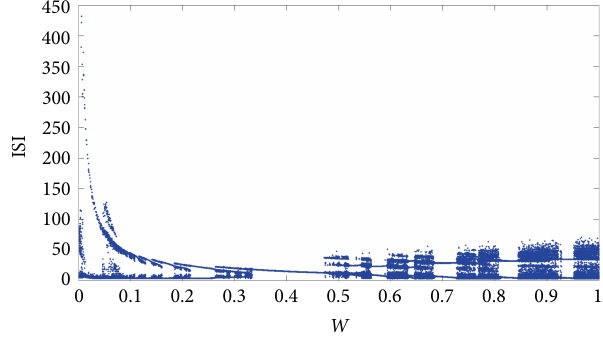
Figure 3: Bifurcation diagram of ISI by setting angular frequency 𝜔 as the bifurcation parameter with 𝐼 = 0.05 . The effect of electromagnetic radiation is considered by setting 𝑘